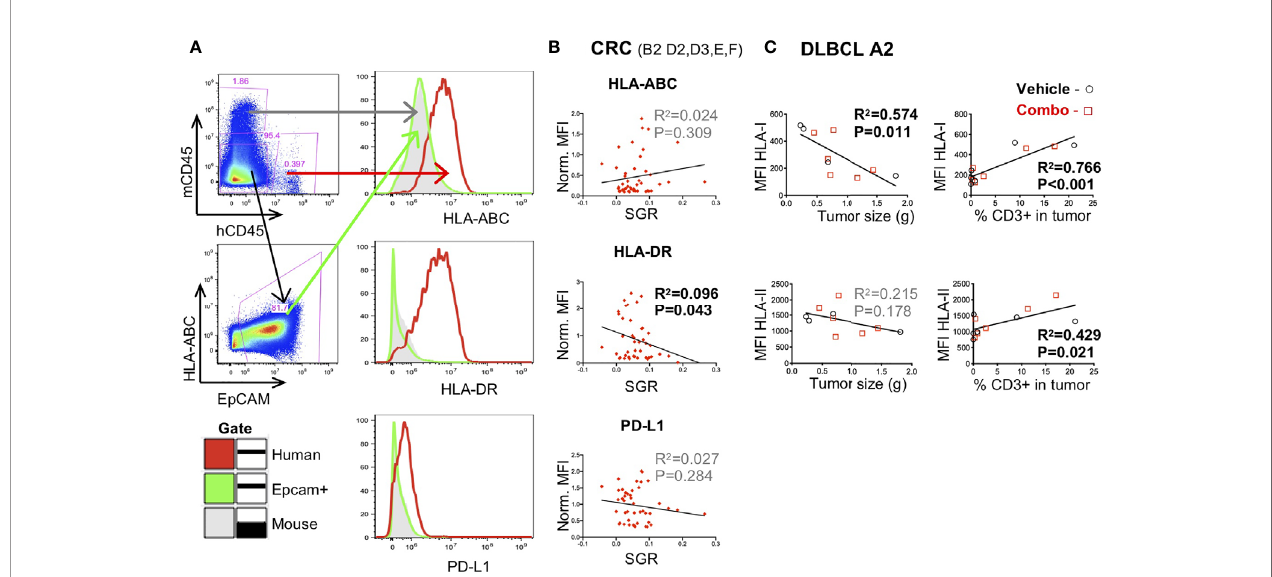
FIGURE 8 | Expression of immune-related molecules on human tumors in HIS-BRGS mice. (A) Representative fl ow cytometry plots illustrating gating for expression on the tumors: mCD45 - hCD45 - cells are gated in the tumor cell suspension and when possible, a tumor-speci fi c Ag (e.g. EpCAM) is included, (B) Correlation of tumor growth rates with expression of human HLA-ABC (MHC Class I), HLA-DR (MHC Class II) and PD-L1 on hCD45 - mCD45 - EpCAM + CRC MSS PDX (B2, D2, D3, E, F) in HIS-BRGS mice. (C) Correlation of tumor weight (grams) and human T (hCD3) cell in fi ltration with expression of human HLA-ABC (Class I) and HLA-DR (Class II) on DLBCL CDX A2 in HIS-BRGS mice. Expression of HLA-ABC, HLA-DR and PD-L1 on hCD45 + and mCD45 + populations serve as positive and negative controls, respectively. [Linear regression analysis, R-squared score (R 2 ) and P value (P) in bold if statistically signi fi cant (P < 0.05)].